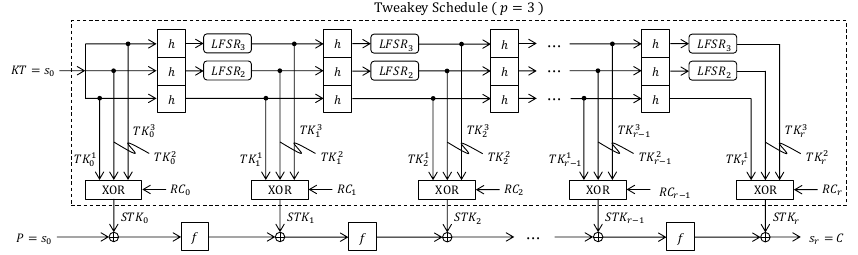
Figure 1: Instantiation of the TWEAKEY framework for Deoxys-BC-384